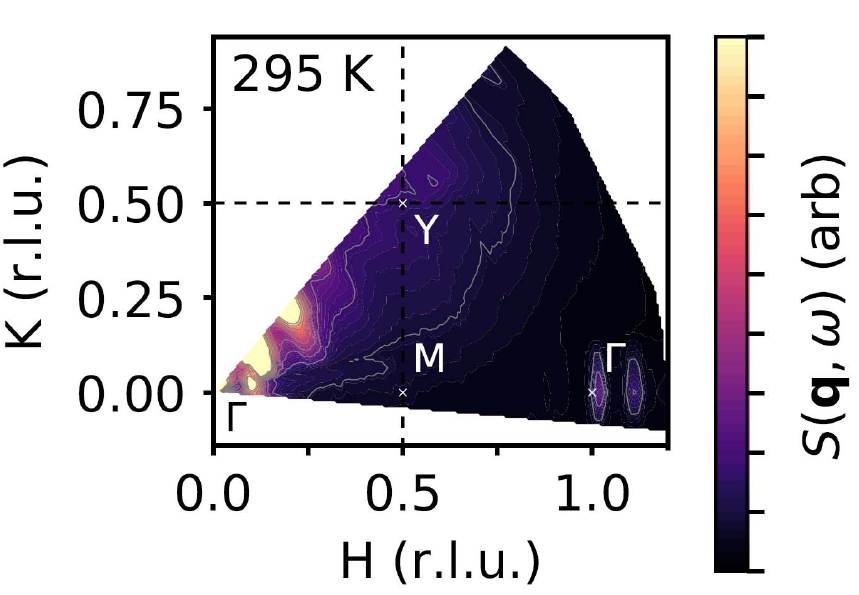
Figure 4: Momentum maps of the quasi-static ( ω = 0) scattering in Bi2212 in the ( H , K ) plane at T = 295